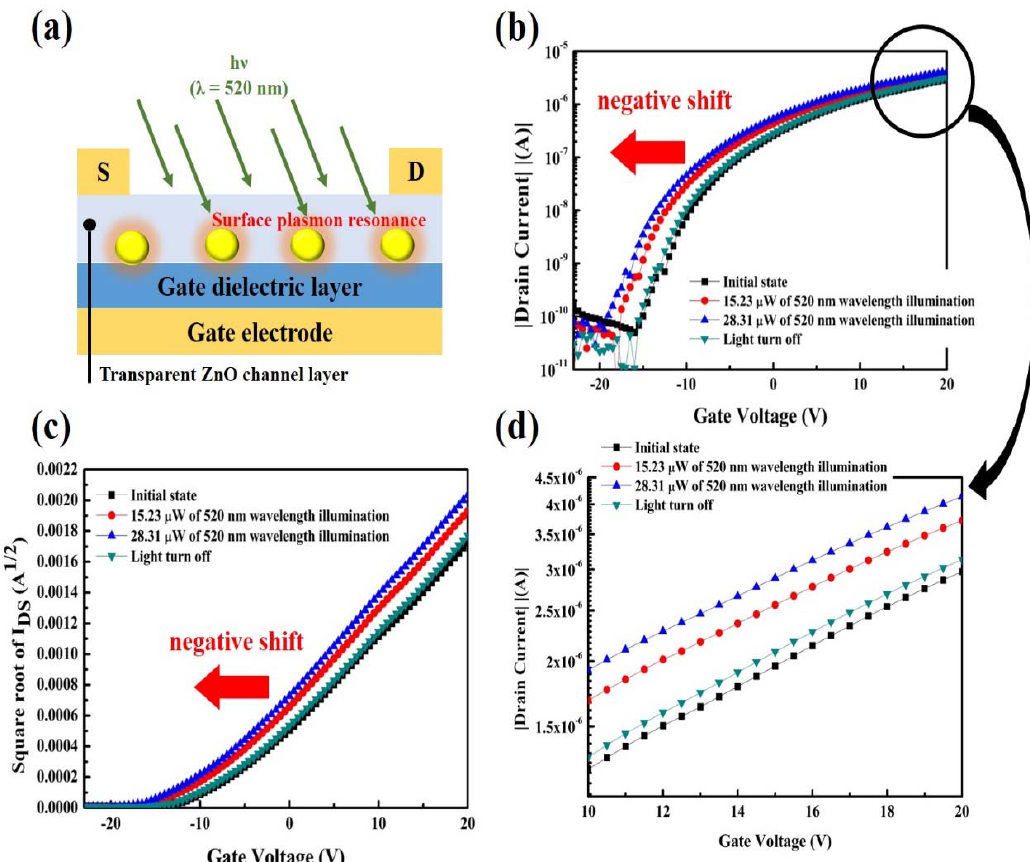
Figure 6. ( a ) Schematic illumination of the device, where Au NPs are inserted at the interface between transparent ZnO channel layer and gate dielectric. ( b ) The I DS –V GS curves of the photodetector under darkness (initial state), under visible light of 520 nm wavelength illumination and with the light turned off and ( c ) square root of the electrical characteristics. ( d ) Amplified saturation current interval from Figure 6b between gate voltage 10~20 volts.